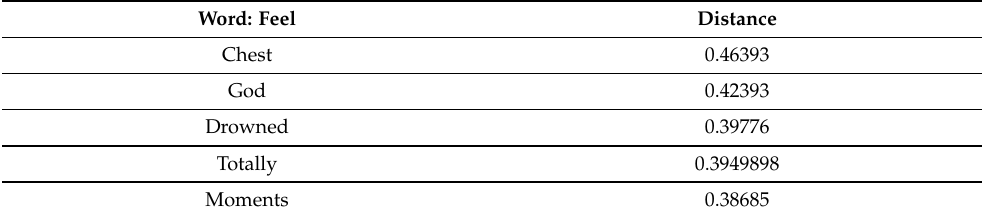
Table 4. Feel’s closest words.